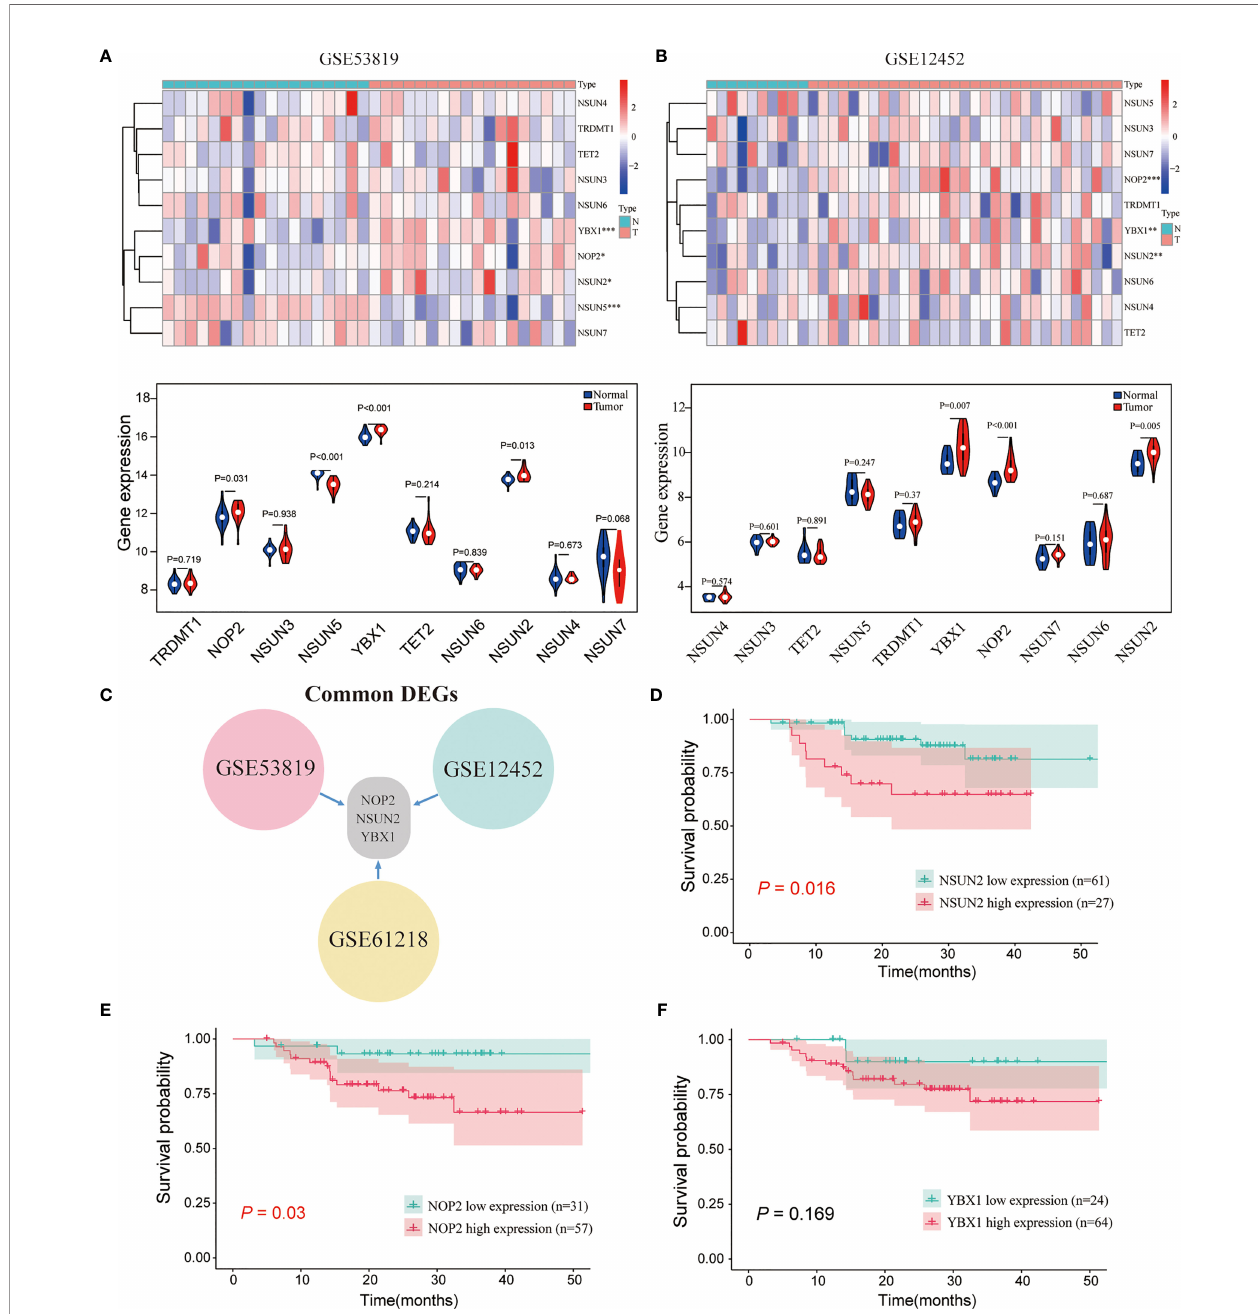
FIGURE 1 | The expression landscape of m5C regulators and the correlations of their expression with the survival of patients with NPC. (A, B) The expression levels of m5C genes in GSE53819 and GSE12452. (C) The common differentially expressed m5C regulators in GSE53819, GSE12452, and GSE61218. Kaplan – Meier curves of PFS for high-and low-NSUN2 (D) , NOP2 (E) , and YBX1 (F) in GSE102349. * P < 0.05, ** P < 0.01, and *** P <